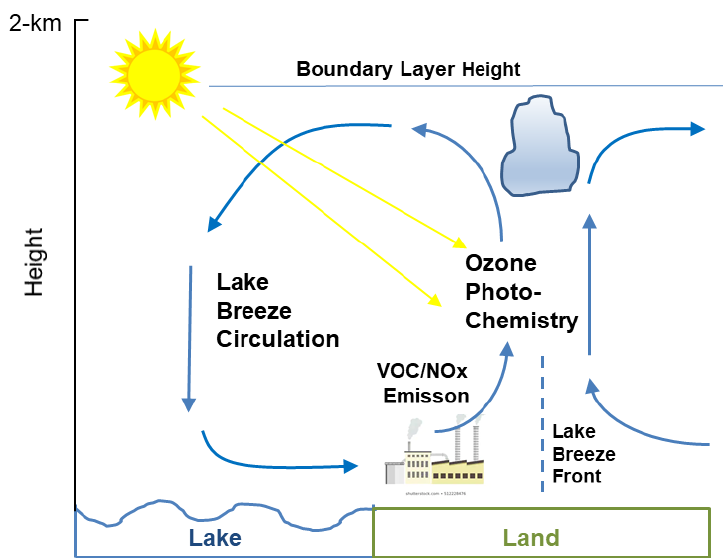
Figure 1. Vertical cross-section diagram of the interactions between a lake-breeze circulation, urban pollutant emissions and ozone photochemistry.